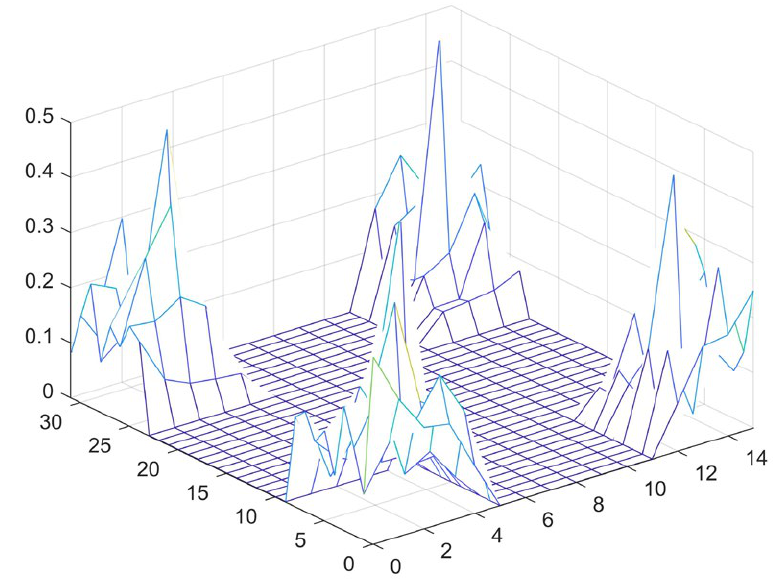
Figure 7. The original angular spectrum.